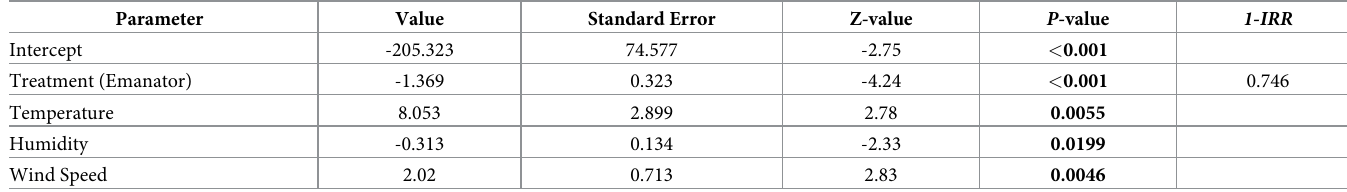
Table 3. IRR estimated from a GLMM with parameters affecting mosquito premise entry and landing